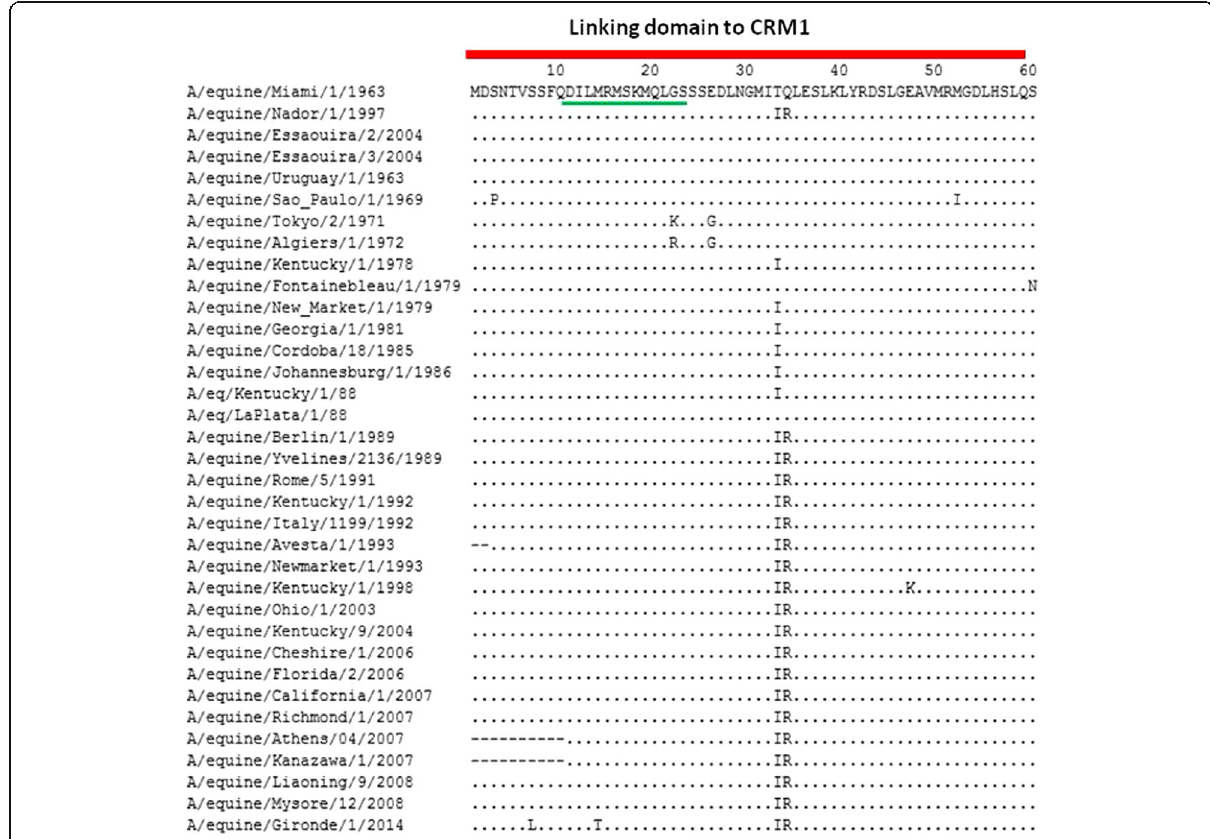
Fig. 3 Alignment of NEP sequences. NS2 protein (1 – 121) with reference strain A/ equine/Miami/1963 (the green line refers to the NES (nuclear export signal). NES, 11 – 23 aa; CRM1-binding domain, 1 – 58 aa; M1-binding domain, 59 – 116 aa (37). Accessions numbers: